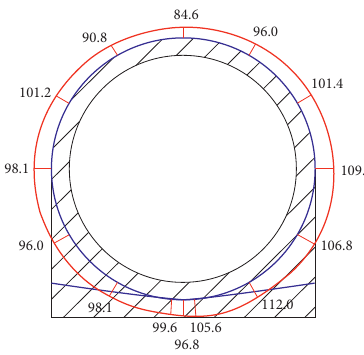
Figure 4: Water head test curve at 60.2m in the water pressure test of the magnetic flux sensor (kN).